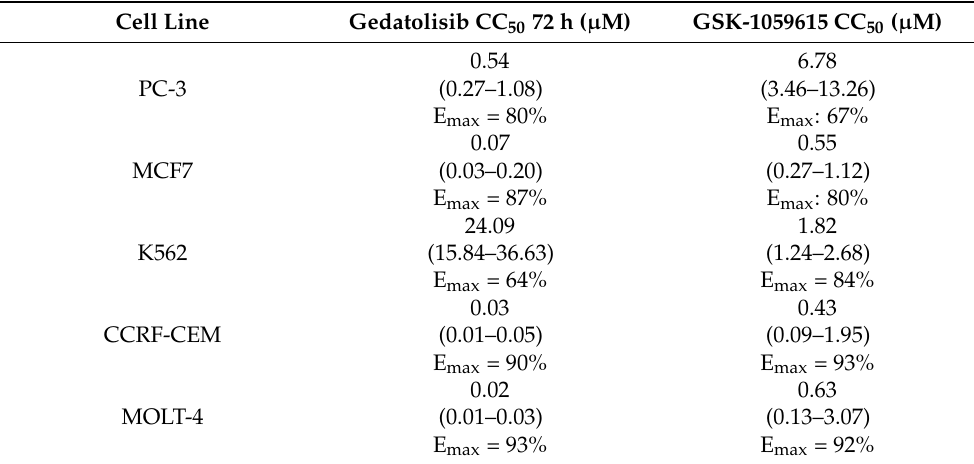
Table 2. CC 50 values calculated from the 72 h MTT cell viability assay.